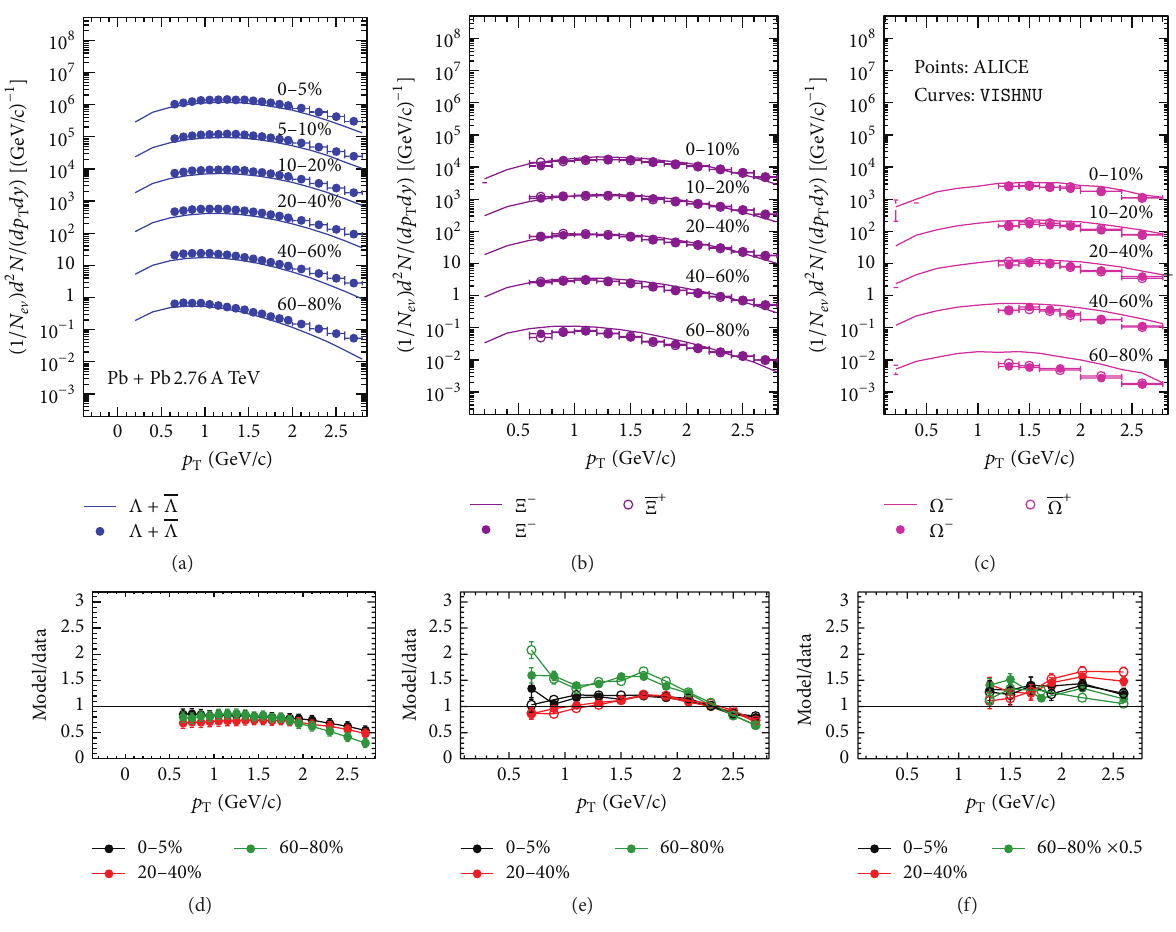
+ + Figure 2: Transverse momentum spectra of Λ + Λ , Ξ − ( Ξ ), and Ω − ( Ω ) at various centralities in Pb + Pb collisions at √𝑠 NN = 2.76 TeV. ExperimentaldataaretakenfromLHC[21,22].Theoreticalcurvesarecalculatedwiththe VISHNU hybridmodelwiththeparameterspresented in Section 2. From top to bottom the curves correspond to 0–10% ( ×10 4 ), 10–20% ( ×10 3 ), 20–40% ( ×10 2 ), 40–60% ( ×10 1 ), and 60–80% ( ×10 0 ) centrality, respectively, where the factors in parentheses are the multipliers applied to the spectra for clear separation. Spectra of Λ start from 0–5% ( ×10 5 ) and 5–10% ( ×10 4 ), instead of 0–10%. In VISHNU , the spectra of particles and corresponding antiparticles are same due to zero net-baryon density used in our calculations. Therefore, only results of particles are shown with solid